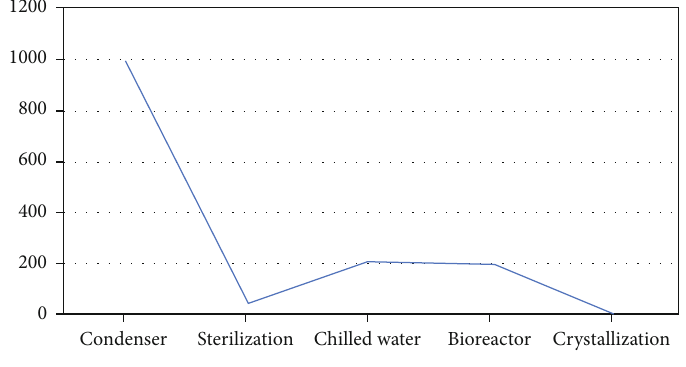
Figure 6: Energy and Utility.